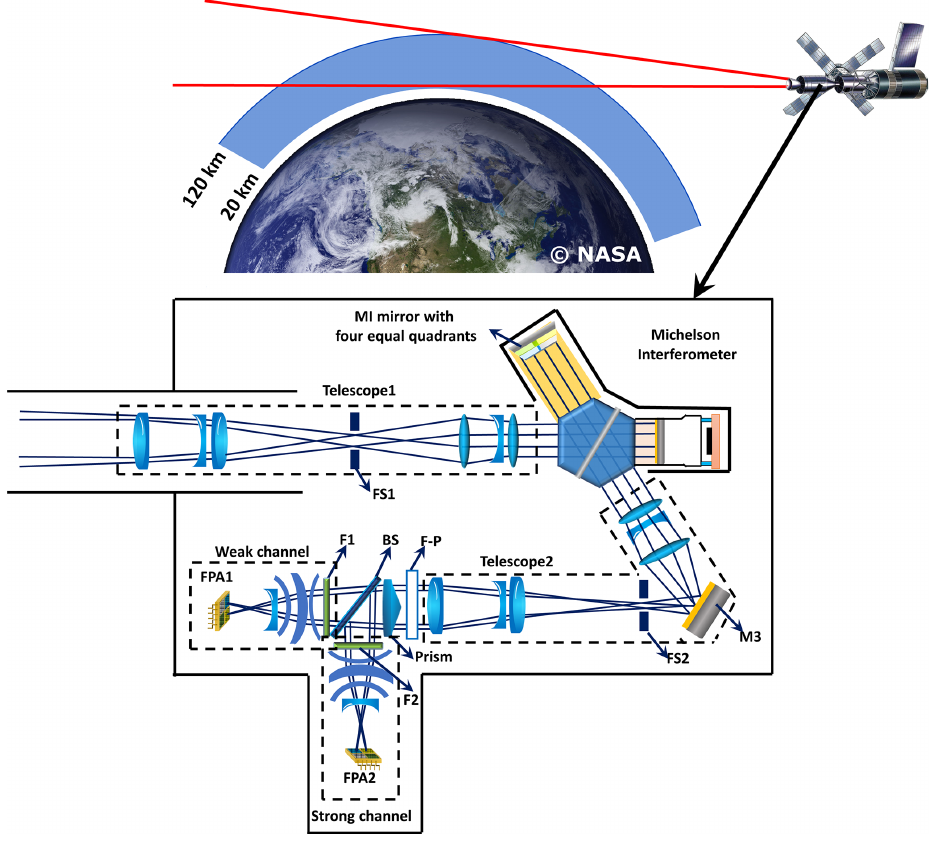
Figure 4. Limb-imaging geometry and optical concept schematic drawing for NWTSI. The background map is from ©NASA (https:// eoimages.gsfc.nasa.gov/images/imagerecords/57000/57723/globe_west_2048.jpg, last access: 12 February 2020).